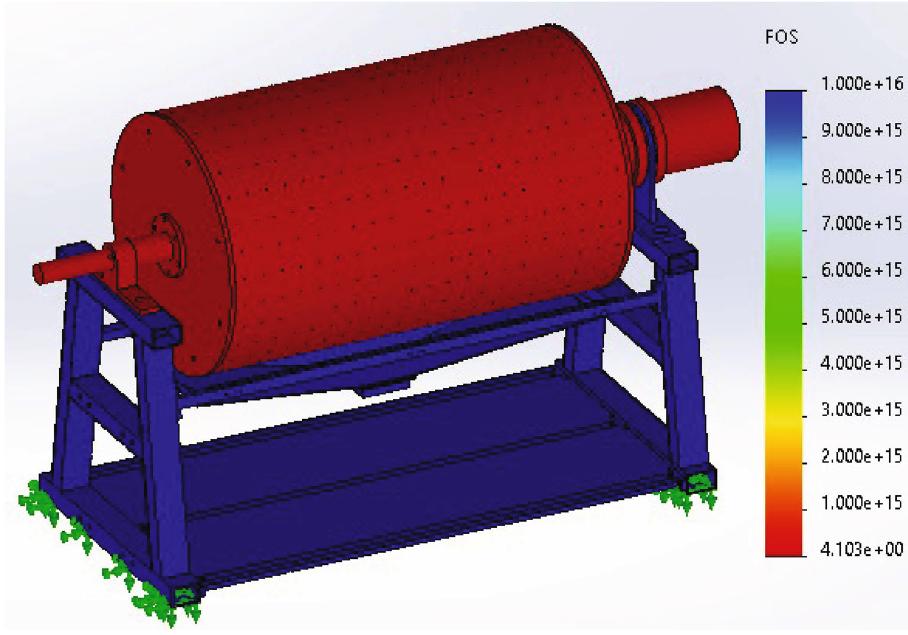
Figure 19: Factor Of Safety against yielding.